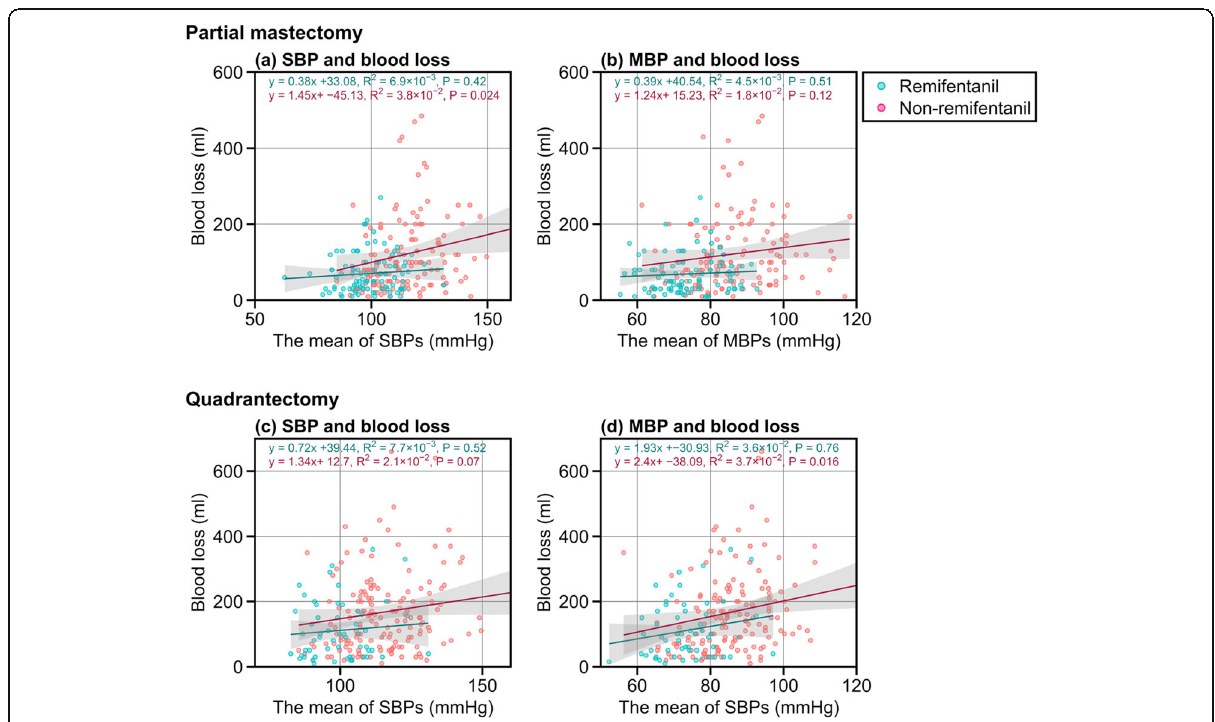
Fig. 3 Linear regression of blood pressure to blood loss in mastectomies. MBP mean blood pressure, SBP systolic blood pressure. a In partial mastectomy, systolic blood pressure (SBP) was positively correlated with blood loss in the non-remifentanil group. b Mean blood pressure (MBP) was not correlated with blood loss. c In quadrantectomy, SBP tended to be positively correlated with blood loss in the non-remifentanil group. d MBP was positively correlated with blood loss in the non-remifentanil